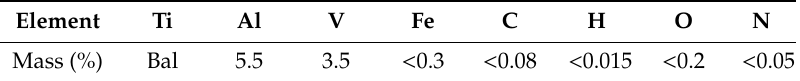
Figure 2. ( a ) SEM image of the spherical Ti-6Al-4V powder for selective laser melting (SLM) manufacturing; ( b ) schematic of the SLM manufacturing process. Table 1. Chemical compositions of Ti-6Al-4V powder.